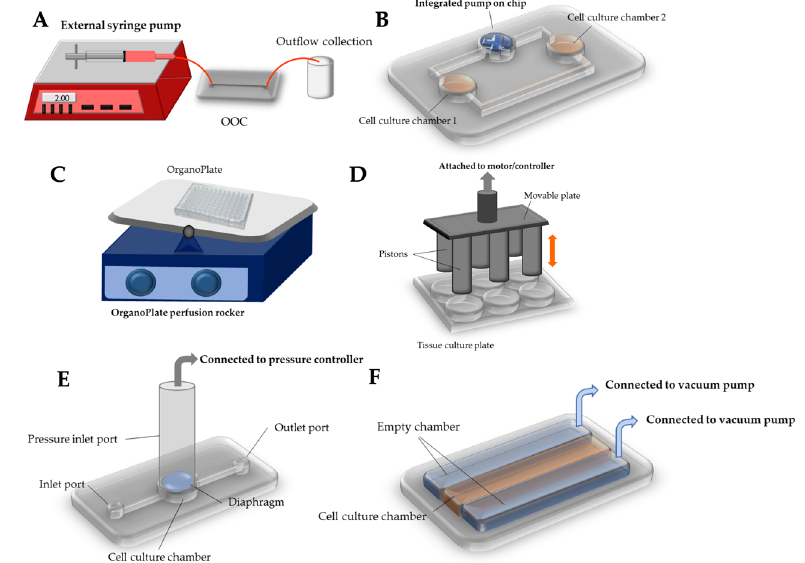
Figure 3. Methods and equipment used to deliver mechanical stimuli to OOC systems. ( A )